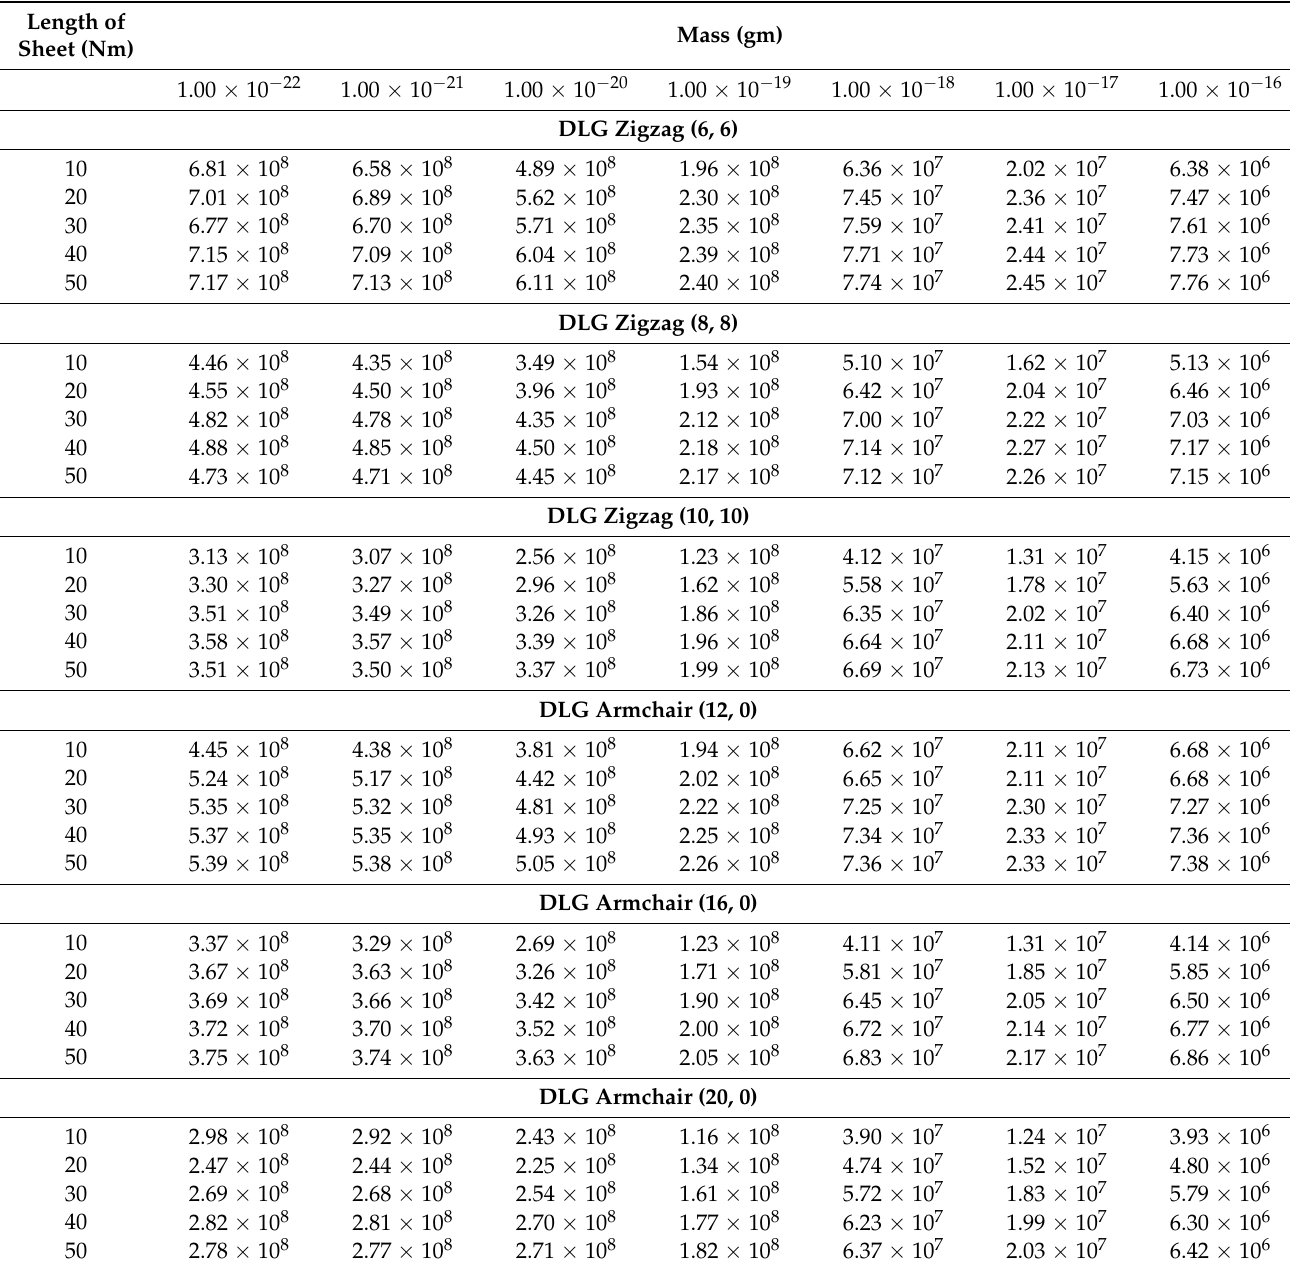
Table 3. Bridged DLG zigzag and armchair with mass addition at centre of